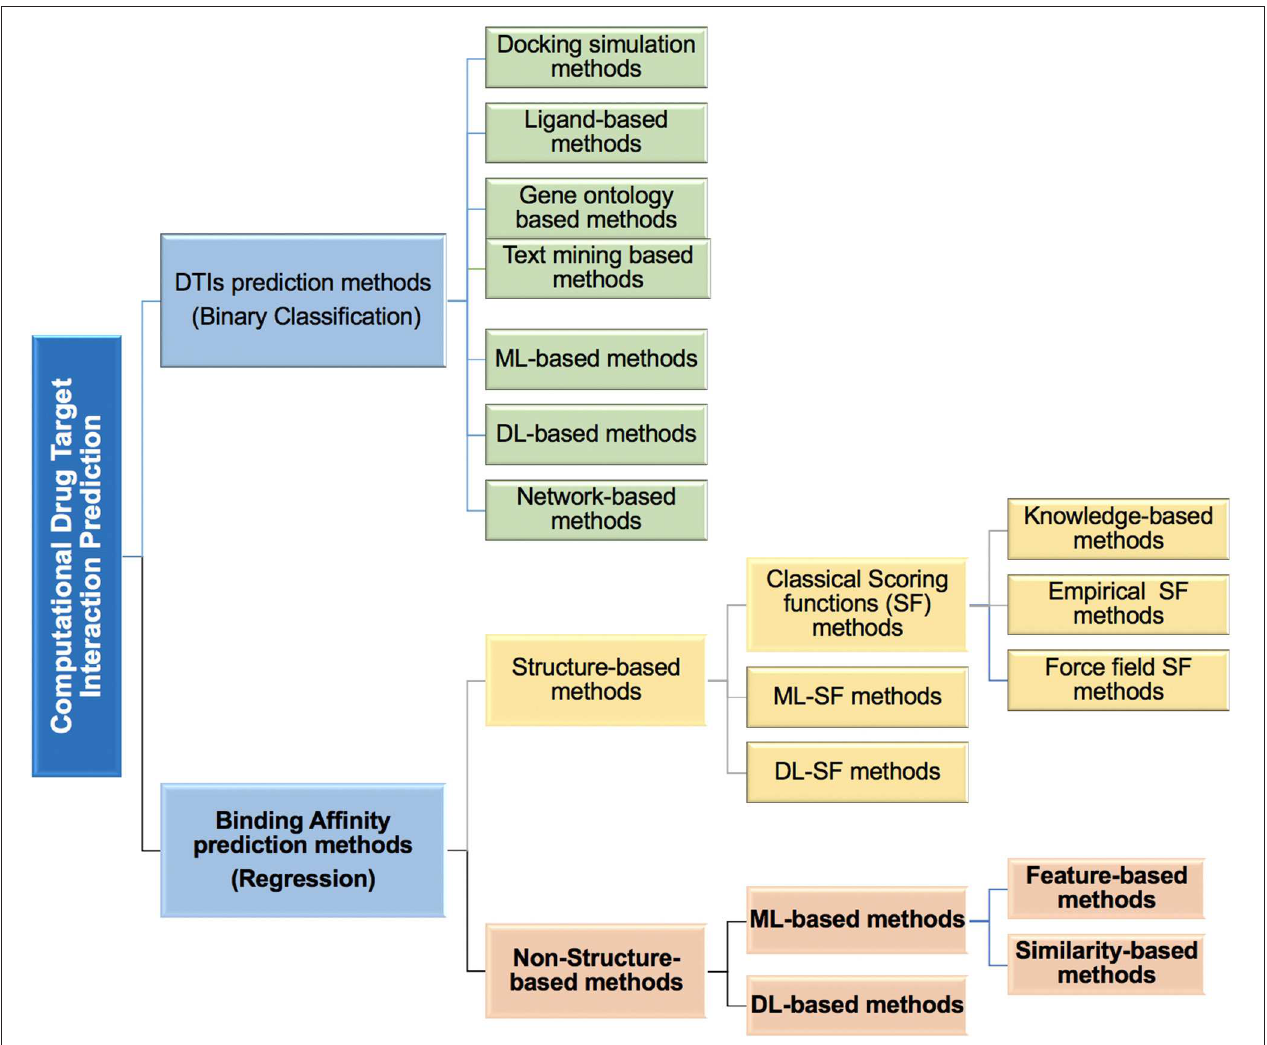
FIGURE 1 | An overview of the different types of computational methods developed to predict drug-target interactions (DTIs) and drug-target binding affinity (DTBA) categories.